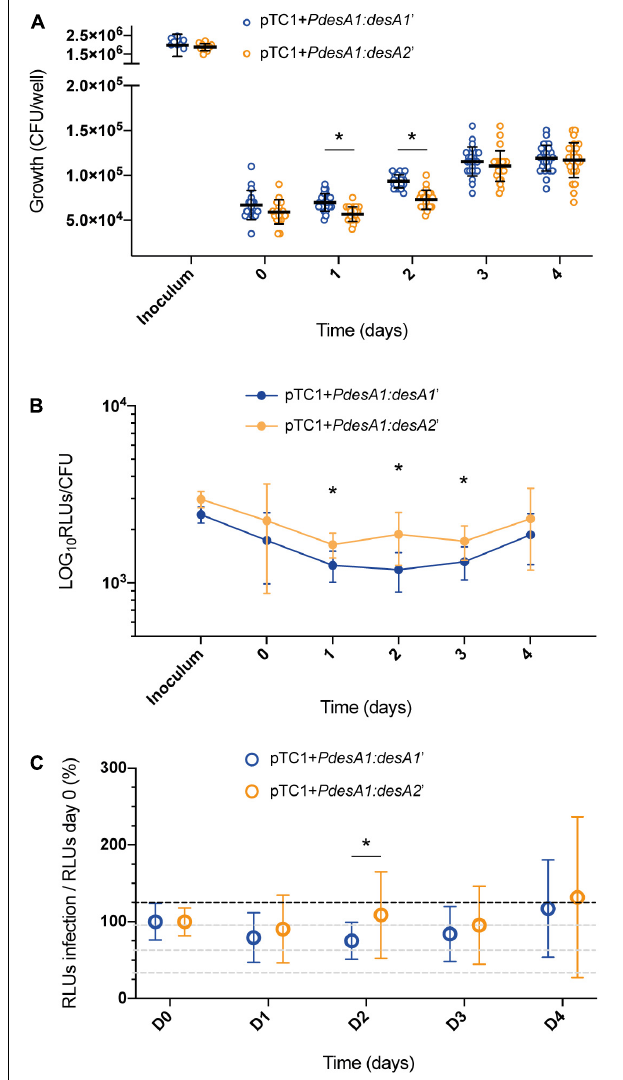
FIGURE 5 | Growth and luminescence production of the leaderless and Shine–Dalgarno reporter strains during infection of THP-1 cells. (A) CFU were counted for 4 days post-infection of THP-1 cells with the M. tuberculosis leaderless (orange) and Shine–Dalgarno (blue) reporter strains. Inoculum represents the CFU/ml used for the infections. Asterisks denote statistically significant differences between the leaderless and Shine–Dalgarno reporter strains (multiple t -tests, p < 0.001). (B) Luminescence, given as relative light units (RLUs) corrected by CFU. Statistically significant differences at day 1, day 2, and day 3 post infection are indicated with an asterisk (multiple t -tests, p < 0.002). (C) To calculate the overall effect that infection of THP-1 cells has on the translation of the reporters, for each timepoint and reporter, the RLU value during macrophage infection was normalized against the RLU after bacterial internalization (time 0). The value obtained at time 0 was considered as the 100% translation efficiency. All experiments were performed in triplicate. Asterisk denotes significant differences (multiple t -test, p <